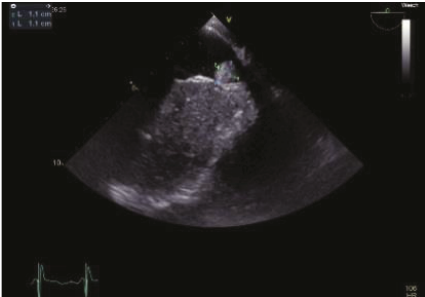
Figure 4: TEE reveals a similar mass in the